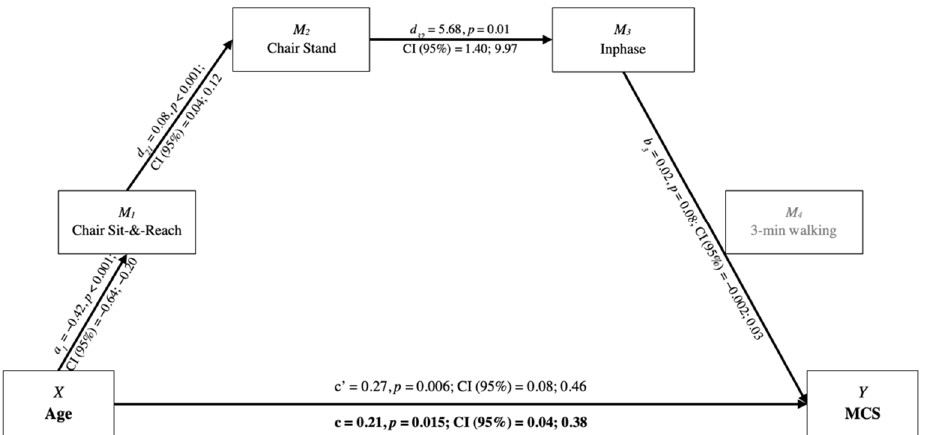
Figure 1. Conceptual and statistical model of age and mediators’ effects on MCS for upper body functional fitness. c’ = direct effect; c = total effect. MCS = Mental Component Summary.